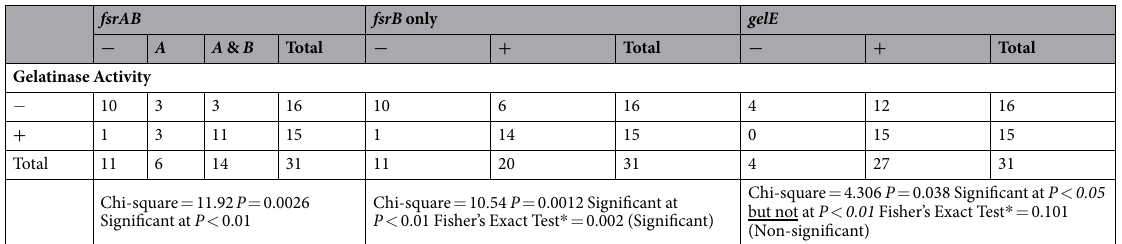
fsrAB fsrB only gelE